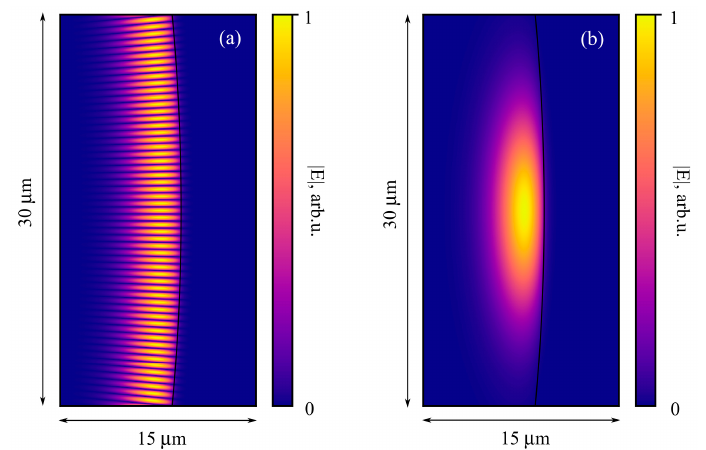
Figure 2. The normalized absolute value of the electric field for transverse electric (TE) mode at the eigenfrequency of about 193.1 THz in the equatorial plane ( a ) and in a plane perpendicular to equatorial one ( b ).